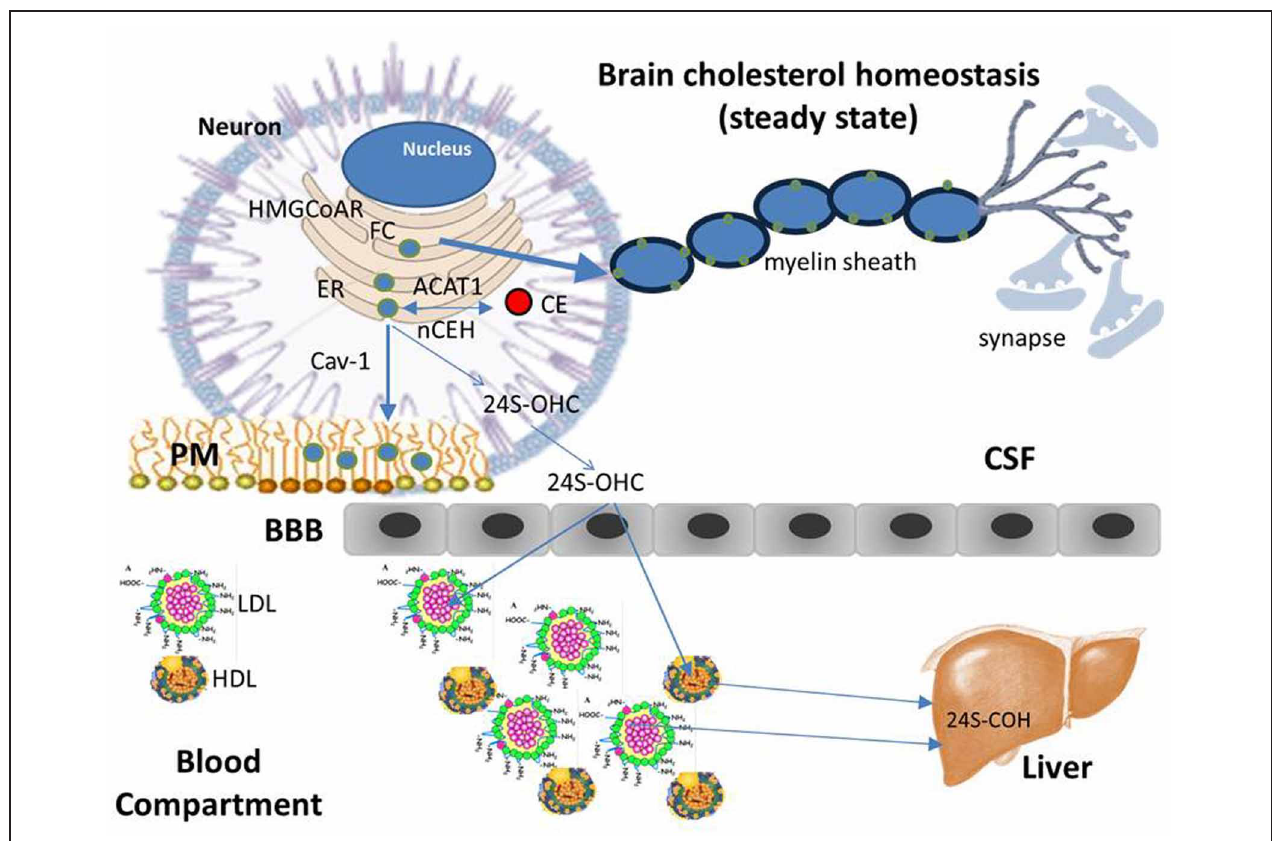
FIGURE 3 | Cholesterol homeostasis (steady state). Differently from the most tissues that take up cholesterol from circulating plasma lipoproteins through the classic mechanism of the low density lipoprotein receptor (LDLR), due to the BBB, brain does not have direct access to cholesterol carried by plasma lipoproteins and therefore, it meets its cholesterol needs through de novo synthesis mainly in glial cells, with only a small amount of cholesterol synthesized in neurons. Glial cells package neo-synthesized cholesterol into Apo E—containing lipoprotein particles, which inturn are secreted into the CSF through the ATP-binding cassette transporter 1 (ABCA1). Apo E-containing lipoproteins are then taken up by neurons and FC released is transported for